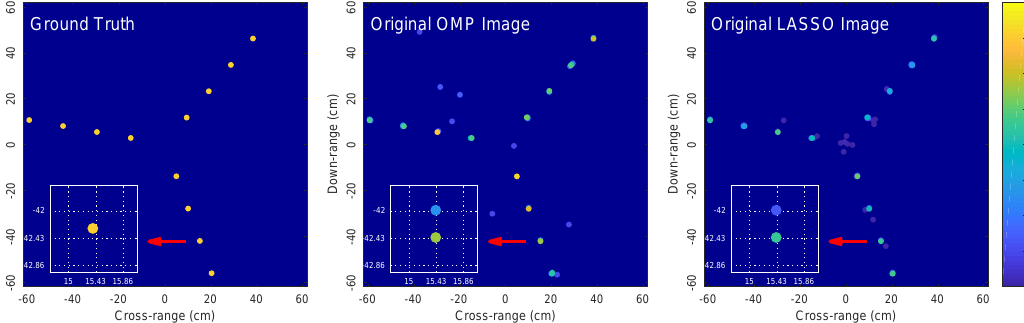
∈ {− 25 λ : λ /7 : 25 λ } and y ∈ {− 25 λ : G , n G , n